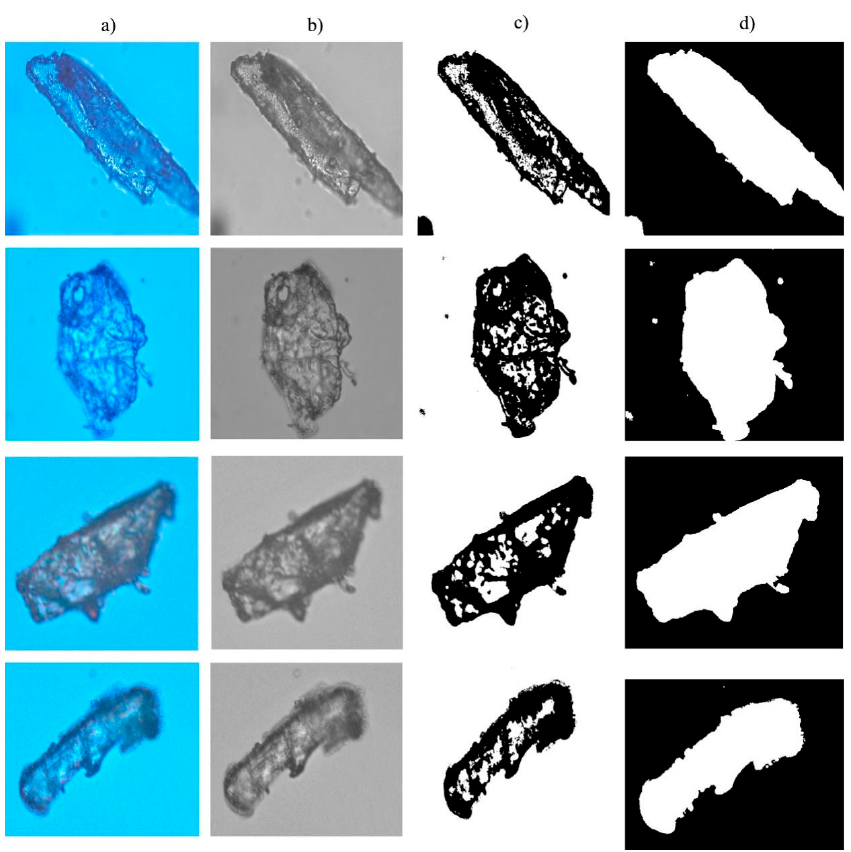
Figure 2. Wood powder particles filling holes: ( a ) Wood flour; ( b ) Grayscale; ( c ) Binary; ( d ) Hole filling.